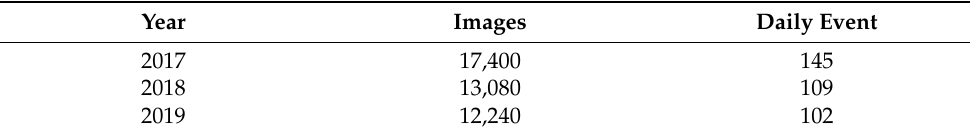
Table 4. Details of the